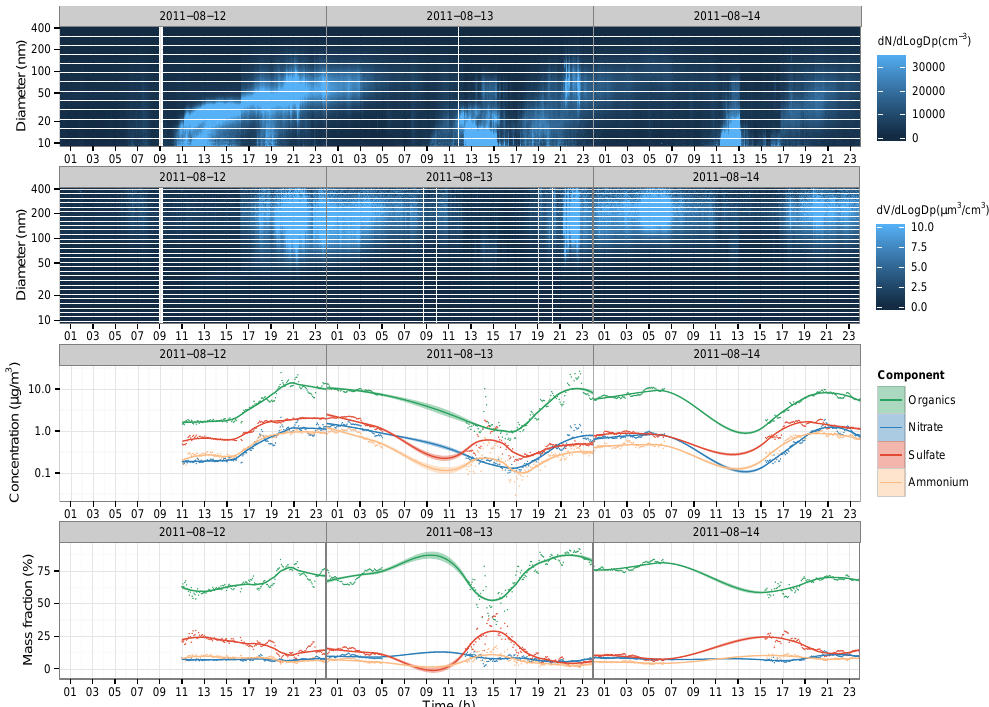
Figure 3. Time series of the particle number/volume size distributions (top two graphs) and mass concentration of particle species and their fraction to the total (bottom two graphs) at s12. Solid lines are calculated using LOESS smoothing technique, and the shaded areas represent the 95% confidence